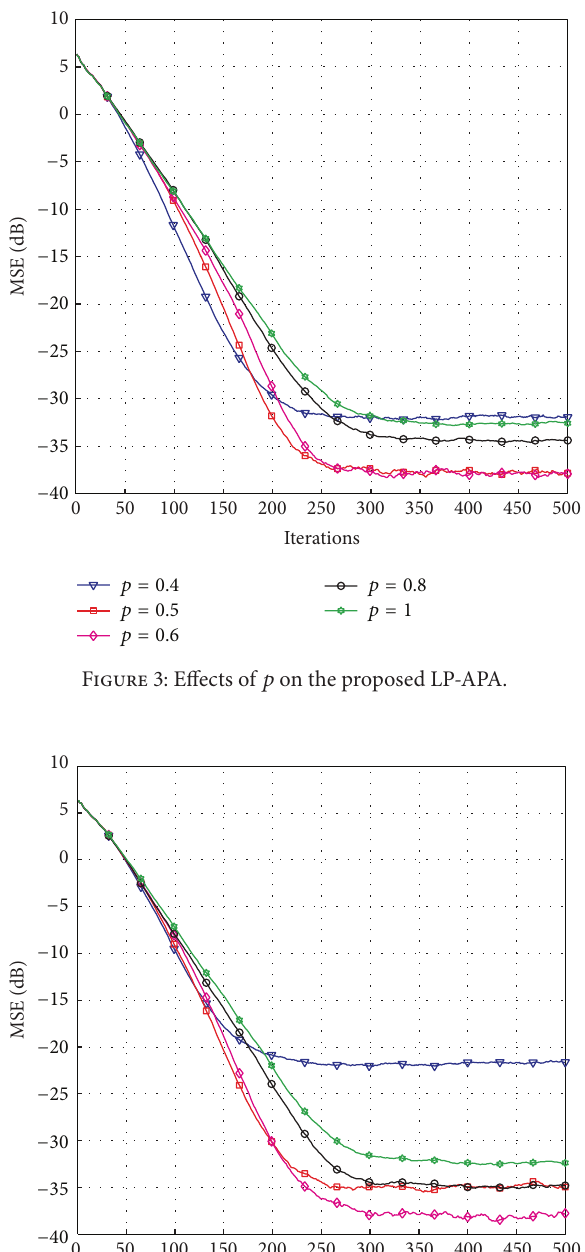
on the proposed LP-APA. LP